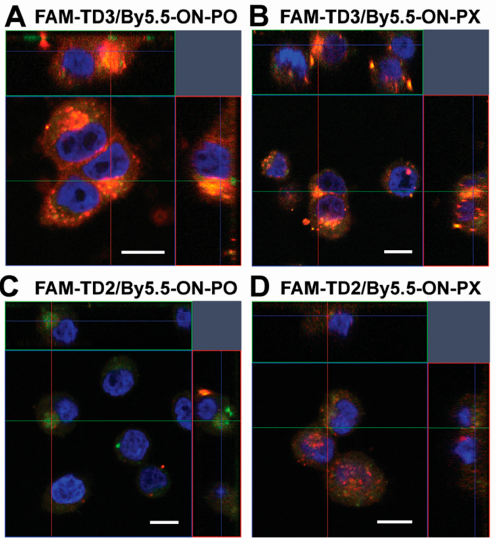
Figure 6. Intracellular localization of duplexes of transport oligonucleotide/antisense oligonucleotide in KB-8-5 cells. ( A) FAM-TD3 / By5.5-ON-PO. ( B ) FAM-TD3 / By5.5-ON-PX. ( C ) FAM-TD2 / By5.5-ON-PO. ( D ) FAM-TD2 / By5.5-ON-PX. Analysis was performed by confocal fluorescent microscopy (Plan-apochromat 63 × / 1.40 Oil DIC M27 objective) 4 h post transfection. Data are presented as orthogonal projections. Blue signal = fluorescence of DAPI (nuclei staining), green signal = fluorescence of FAM-tONs, red signal = fluorescence of By5.5-dONs. Scale bar: 10 µm.